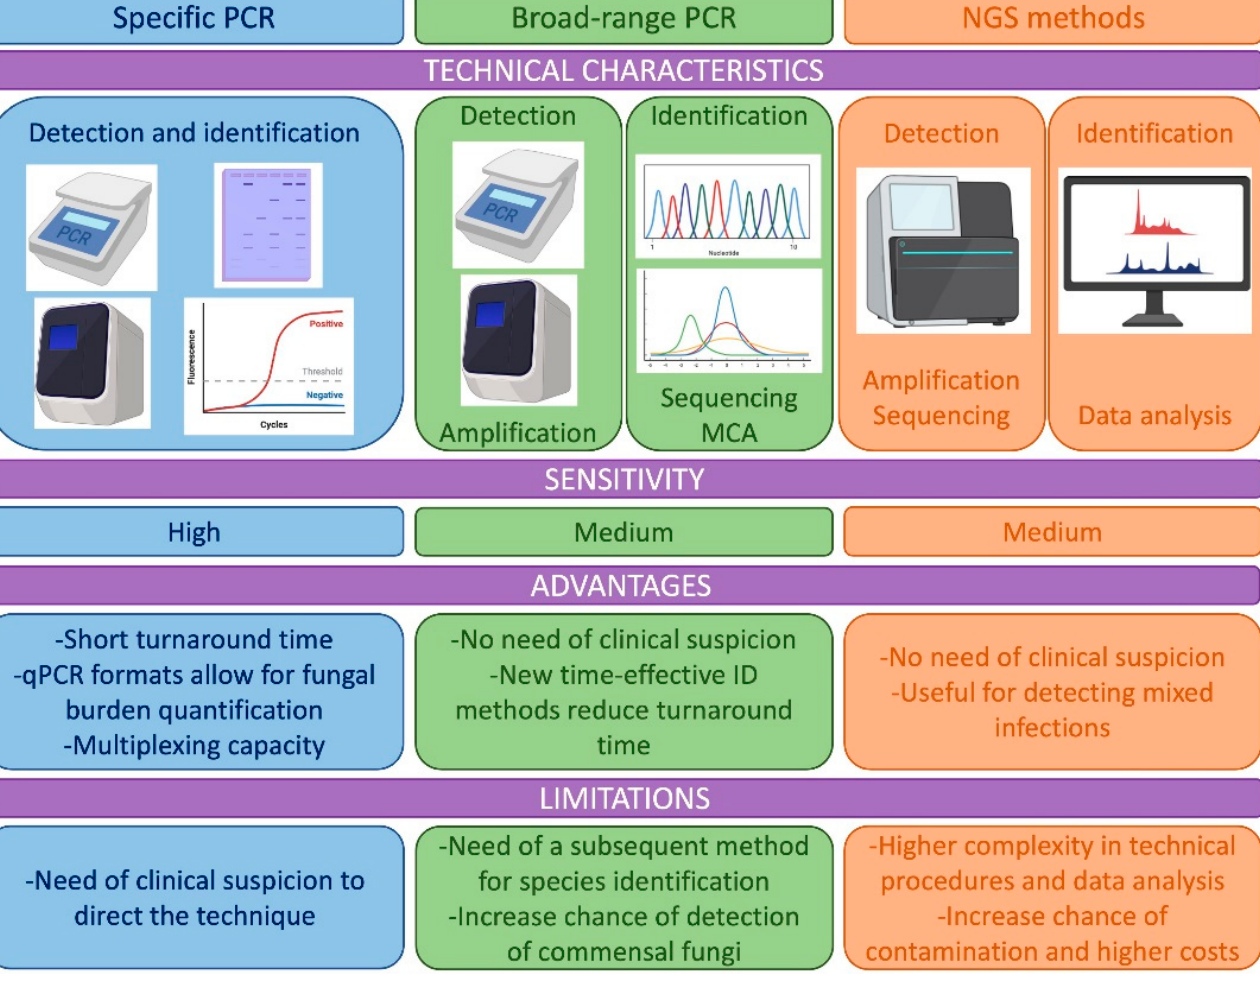
Figure 1. Description of the technical characteristics, advantages and limitations of the molecular methods used for the diagnosis of endemic mycoses including specific PCR methods, methods based on broad range PCR and new methods as those based on Next Generation Sequencing (NGS). MCA: melting curve